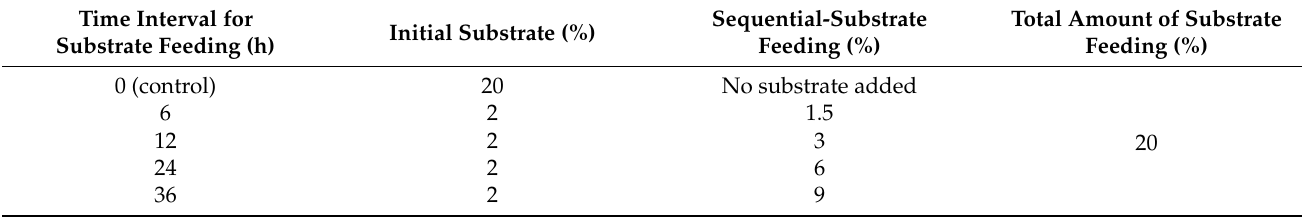
Sequential-Substrate